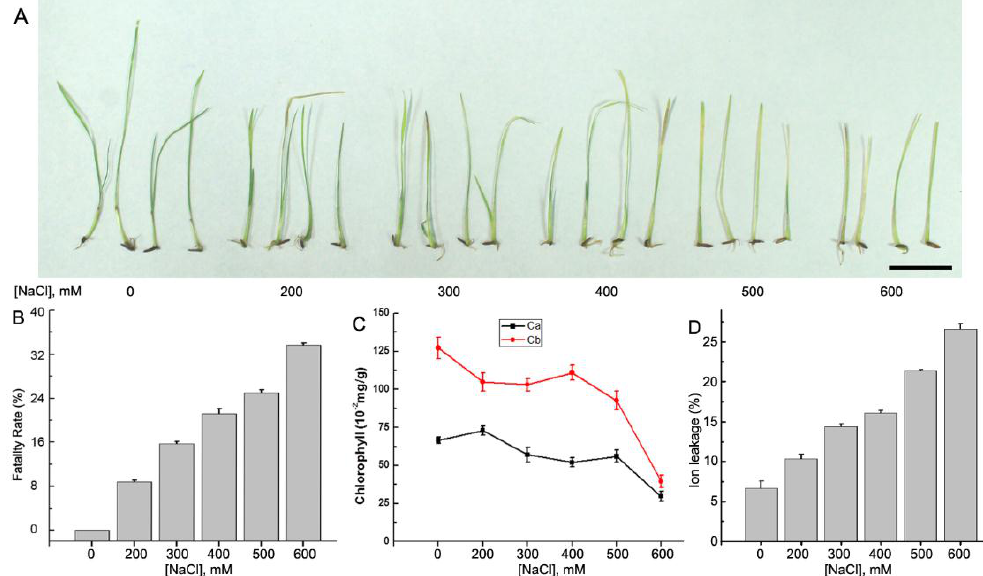
Figure 1. Salt responses of A. splendens . ( A ) Plant seedlings were treated with different concentrations of salt (0, 200, 300, 400, 500, and 600 mM NaCl for 10 days, respectively). Bar = 1 cm; ( B ) fatality rates of A. splendens control and treated seed samples; ( C ) the chlorophyll a and b concentrations in the control and treated seedlings; and ( D ) ion leakage from the leaves of control and treated seedlings. Each treatment was repeated five times.